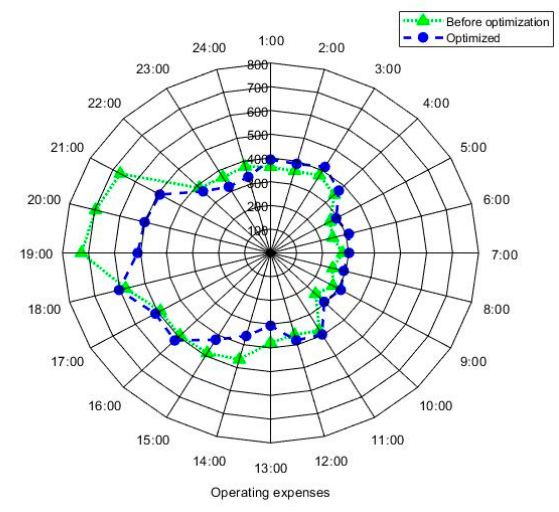
Figure 13. Economic benefits of micro-grids at various times.